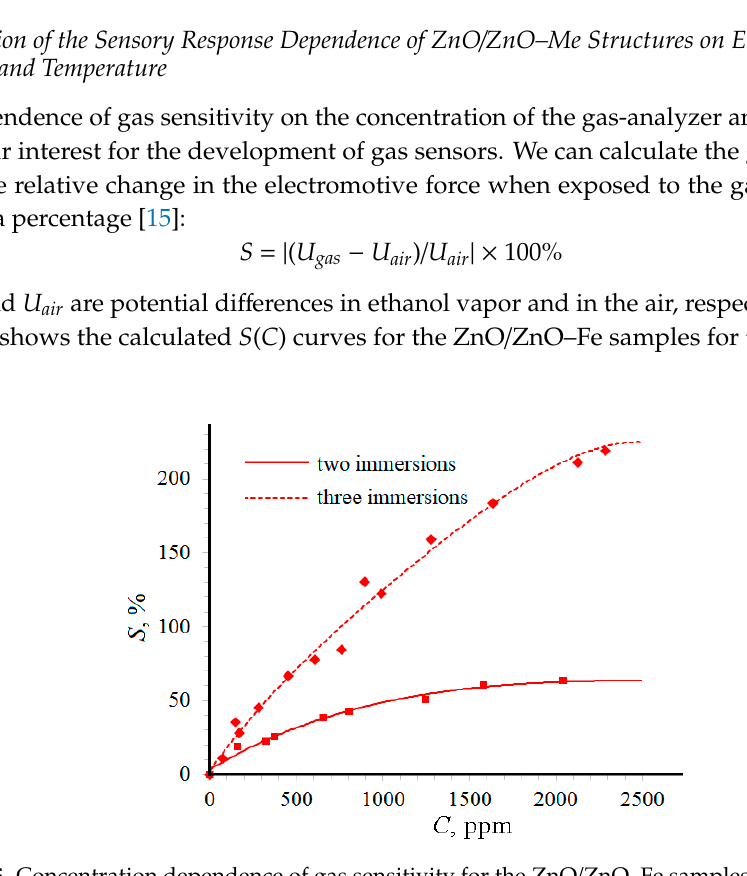
Figure 5. Concentration dependence of gas sensitivity for the ZnO/ZnO–Fe samples ( T = 200 ° С ).